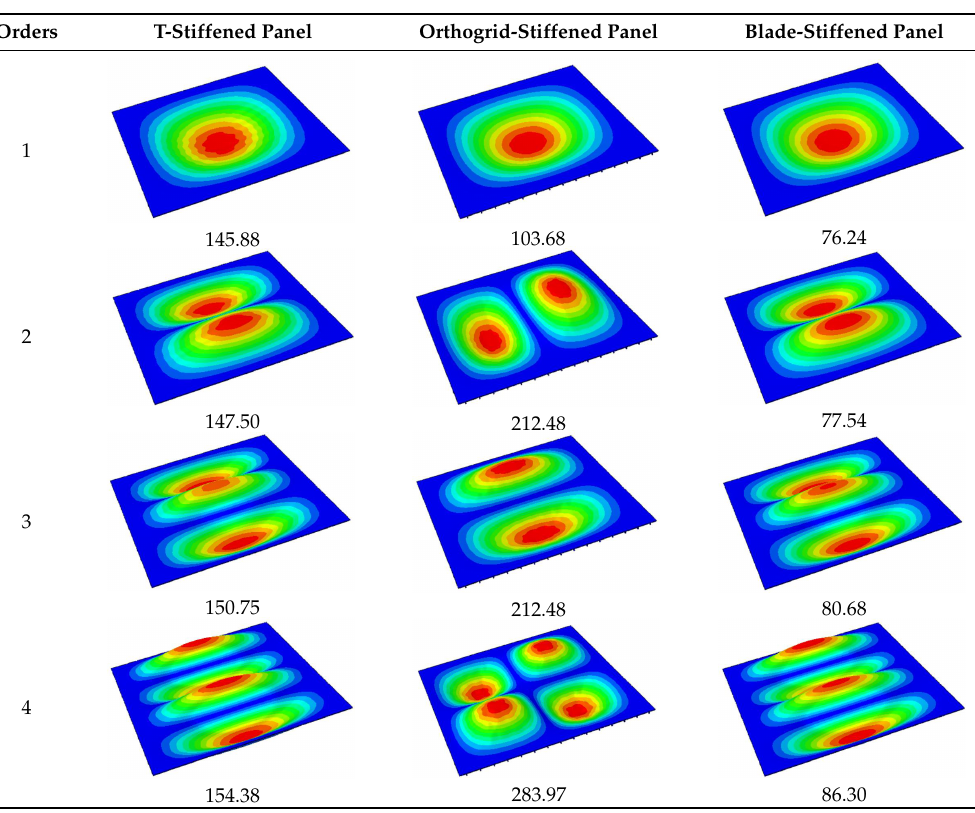
Table 4. Influence of the different stiffening forms on the natural frequencies (Hz) of stiffened FRP panels under the CCCC boundary